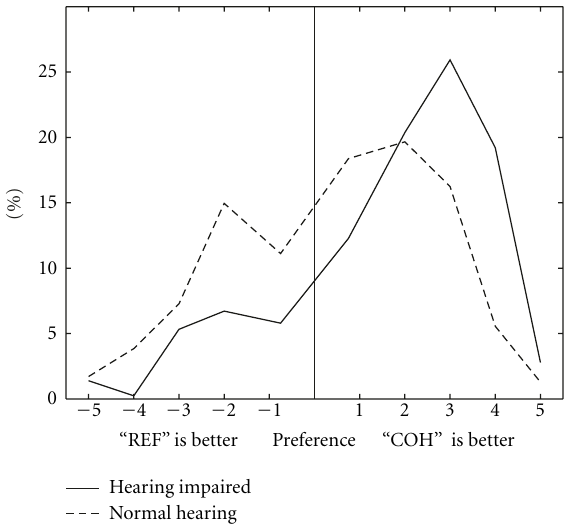
Figure 5: Preference histogram. COH is preferred against the reference condition “REF” by 80.6% of the hearing impaired and by 61.1% of the normal hearing subjects. The categories 1–5 are “very slightly better,” “slightly better,” “better,” “much better,” and “very much